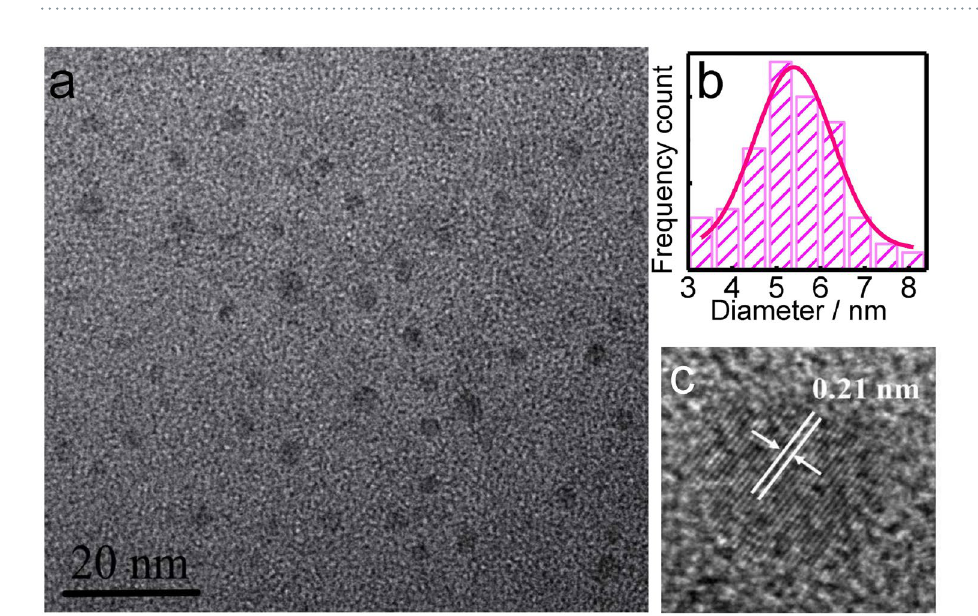
Figure 2. ( a ) TEM graph of the obtained CDs. ( b ) Size distribution of CDs. ( c ) HRTEM image of the CDs showing their lattice